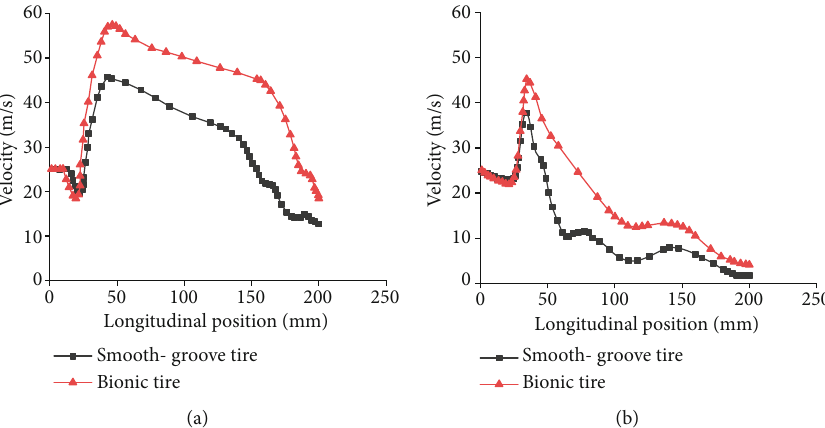
Figure 16: Velocity distributions of longitudinal grooves at di ff erent positions. (a) Central longitudinal grooves; (b) Lateral longitudinal